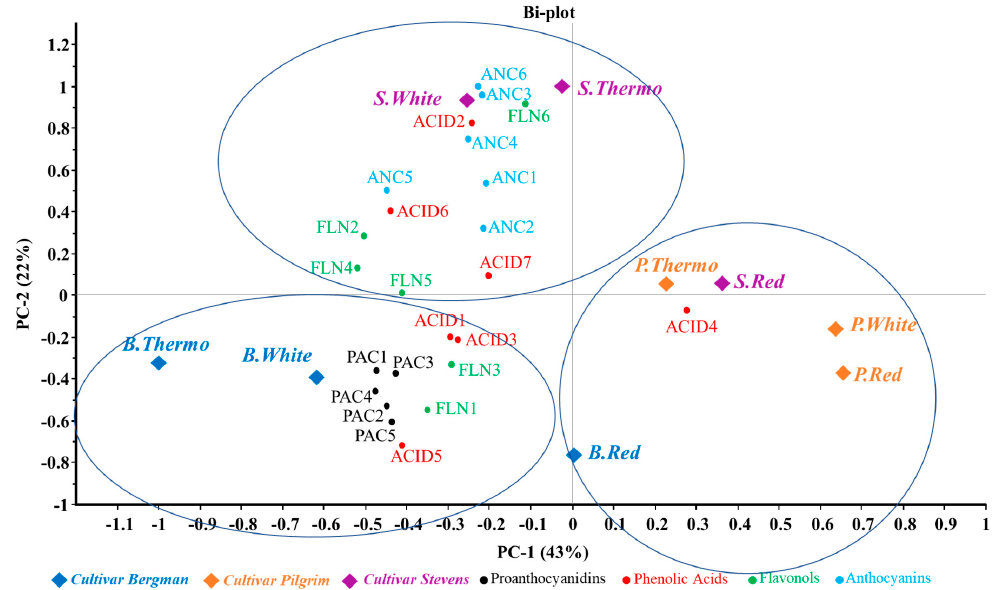
Figure 2. Principle component analysis (PCA) of phenolic compounds. The compound names were represented by code (PAC: proanthocyanins, ACID: phenolic acids, FLN: flavonols, ANC: anthocyanins; PC-1: 1st principal component; PC-2: 2nd principal component; B.Thermo: Thermovinification; B.White: White vinification; B.Red: Red vinification; S.White: Stevens White; S.Thermo: Stevens Thermo; S.Red: Stevens Red; P.Thermo: Pilgrim Thermo; P.White: Pilgrim White; P.Red: Pilgrim Red; B.Thermo: Bergman Thermo; B.White: Bergman White; B.Red: Bergman